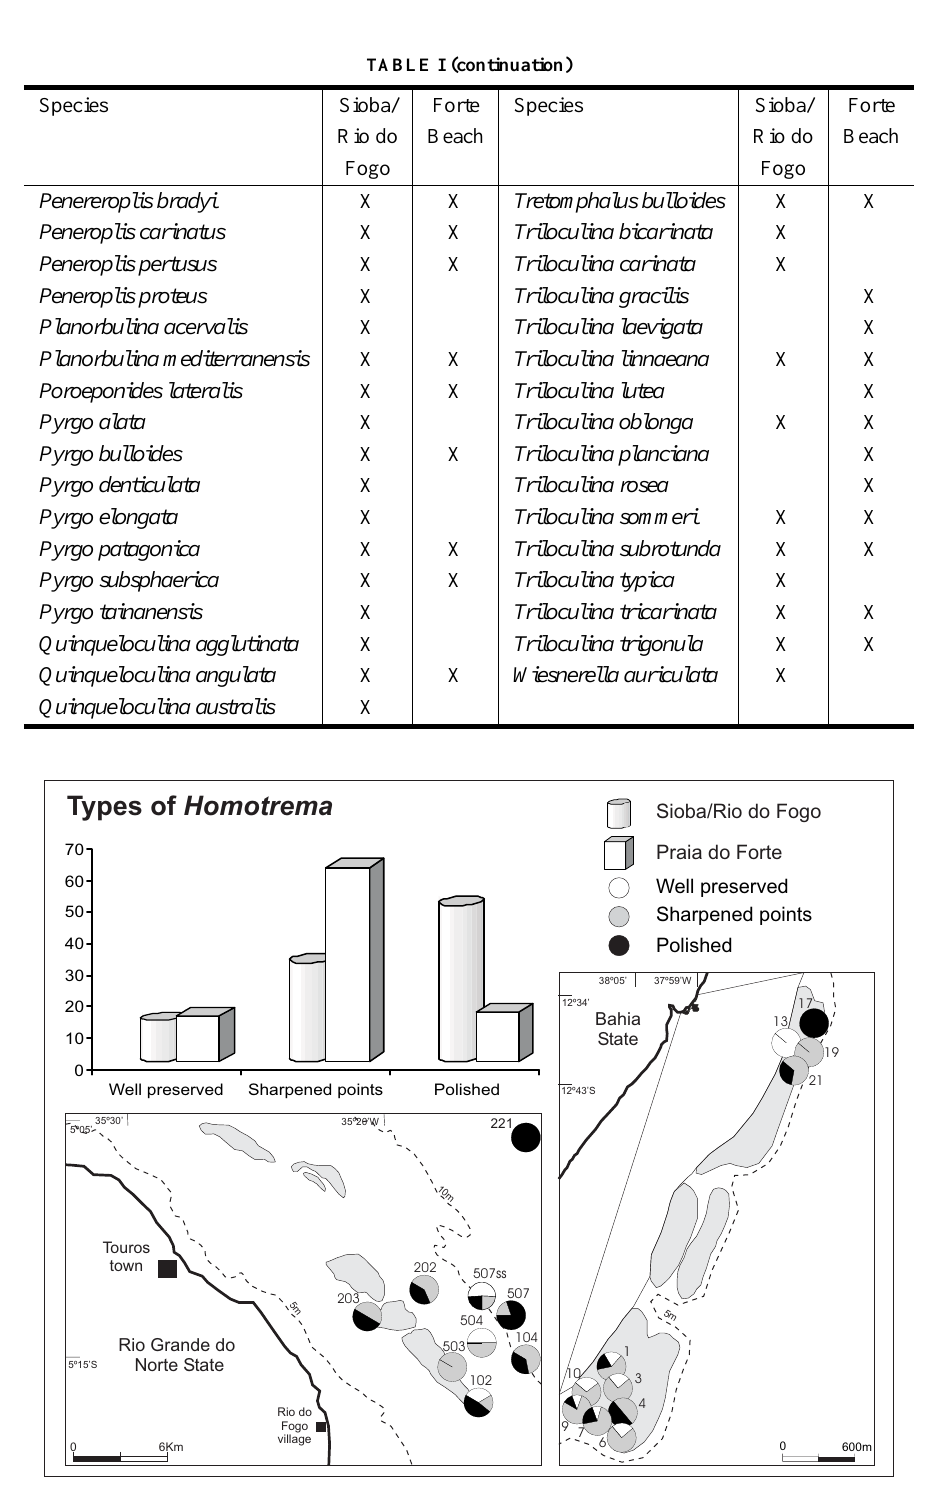
Fig. 2 – Distribution of the major types of Homotrema fragments found in the studied reef